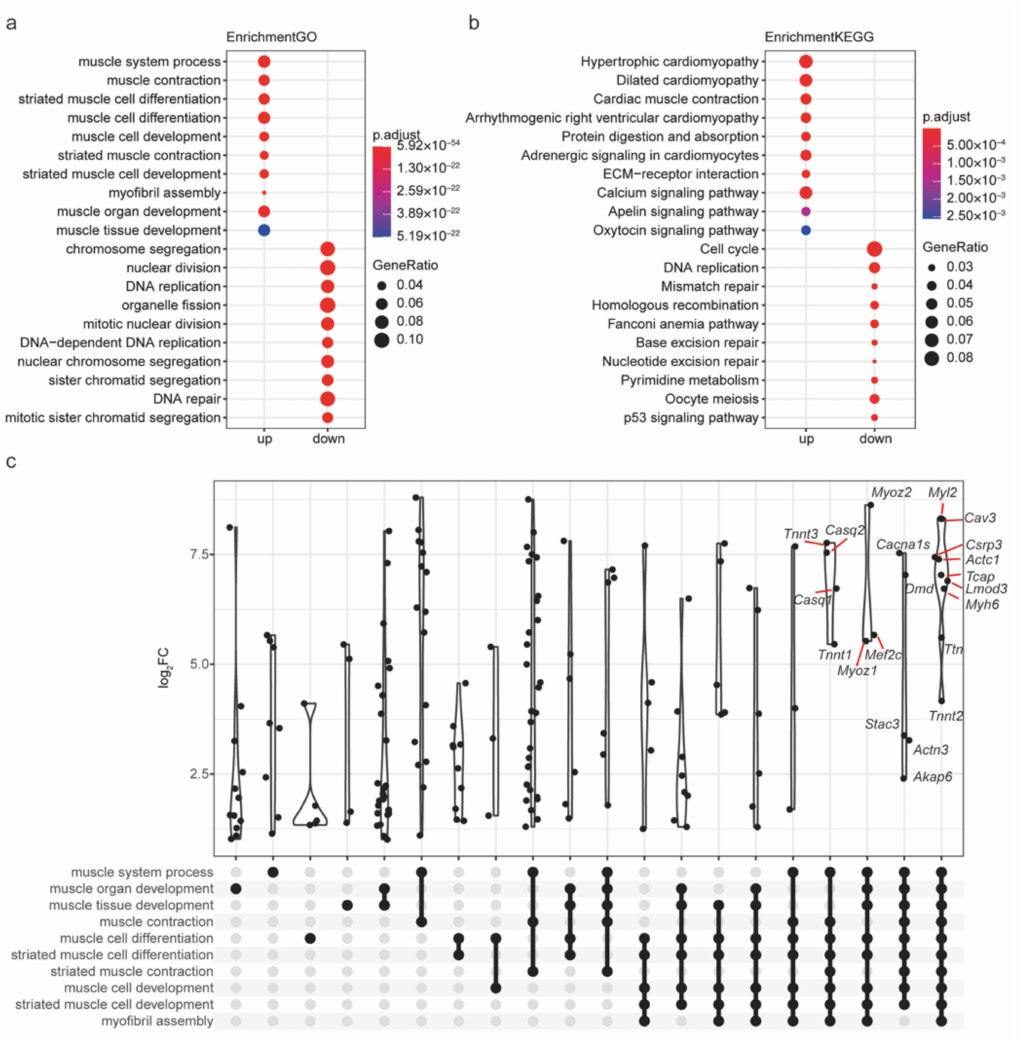
Figure 5. Enrichment analysis of robust DEGs for GO/KEGG terms. ( a ) Top 10 GO biological pro- cesses and ( b ) top 10 KEGG pathways enriched for up- and downregulated robust DEGs, respectively. ( c ) The overlapping genes among the GO terms enriched for upregulated robust DEGs. The log 2 FC represent log 2 (fold change) of the gene expression